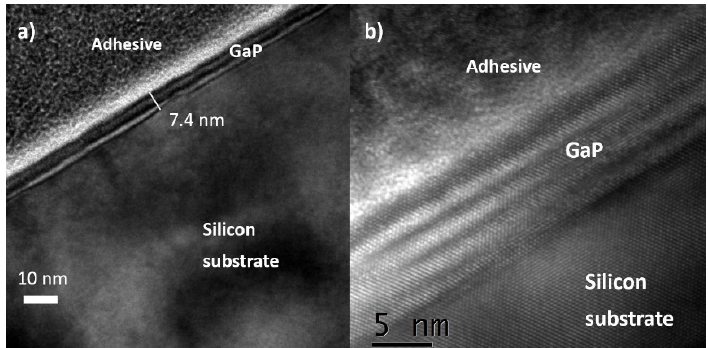
Figure 7. TEM images of the GaP nucleated on Si that followed the routine of the sample of Figure 5 of 100 nm × 100 nm ( a ) and 40 nm × 40 nm ( b ).